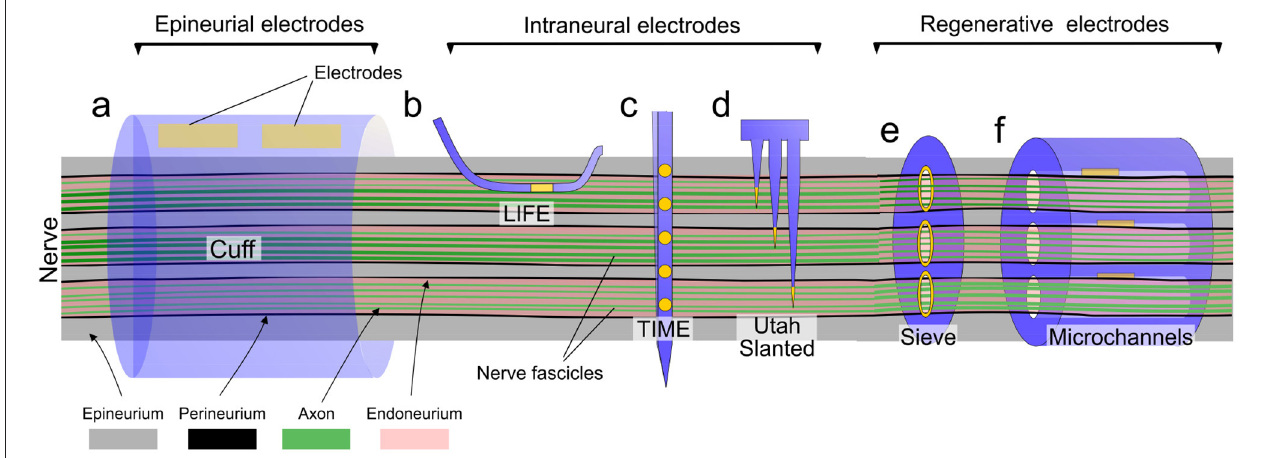
FIGURE 4 | Overview of different types of nerve neuroprosthetic designs and their implantation locations within the nerve anatomy. (a) Epineurial cuff electrodes, (b) Longitudinally implanted intrafascicular electrodes (LIFE), (c) Transverse intrafascicular multichannel electrodes (TIME), (d) Utah slanted electrode array, (e) Regenerative sieve electrodes, (f) Regenerative microchannel